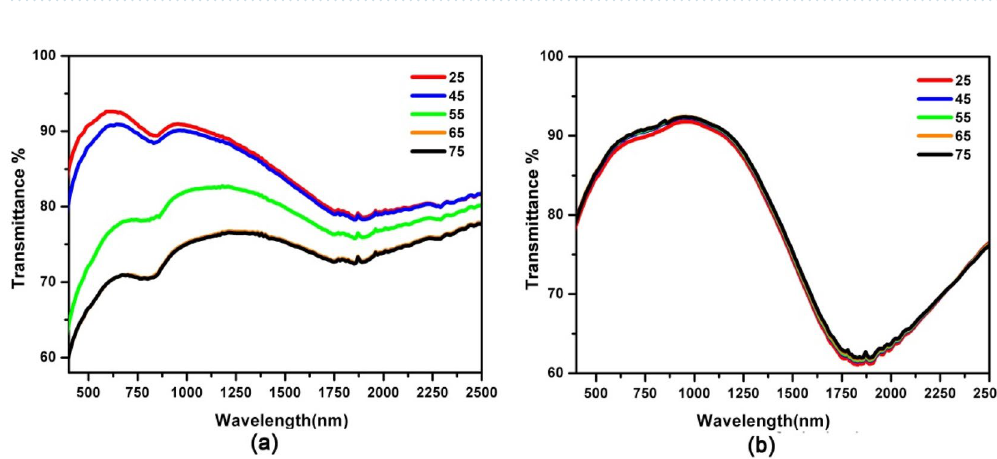
Figure 5. Transmission spectra of ( a ) ITO-NC@copolymer/PCL (INCP) and ( b ) ITO-NC@ copolymer films at between 25–75